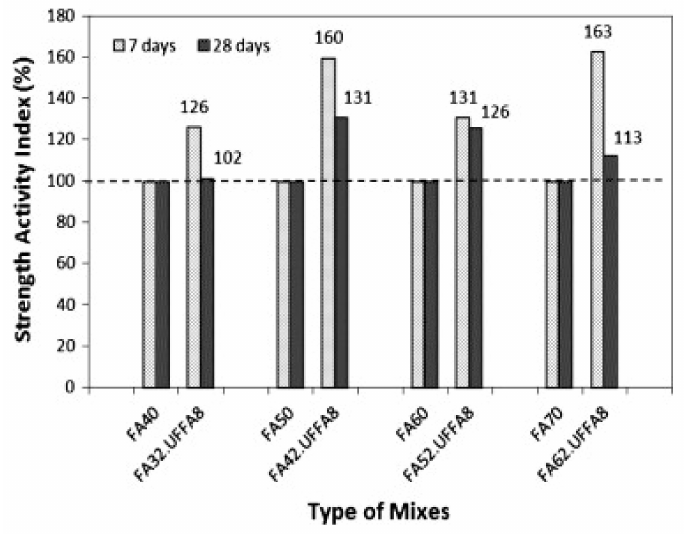
Figure 10. Strength activity index versus type of mixes with ultra-fine FA [151]. Reprinted with permission from Elsevier